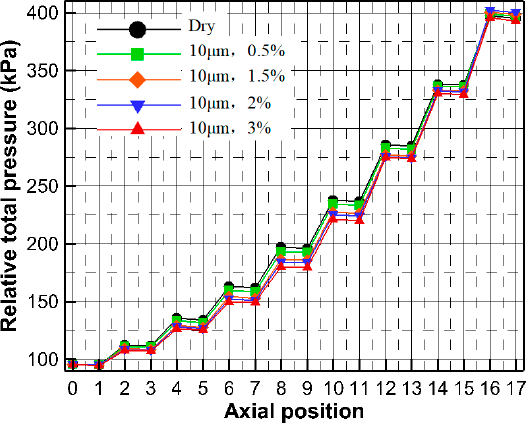
Figure 28. Axial variation of relative total pressure under water of different injecting rates.